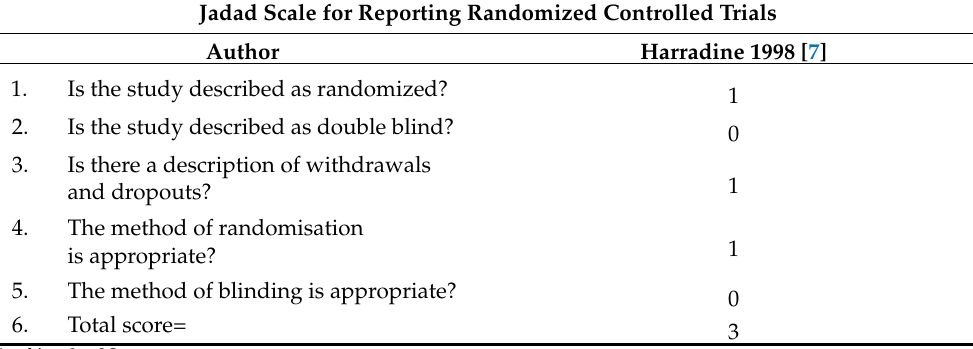
Table 2. Jadad scale for reporting randomized controlled trials.